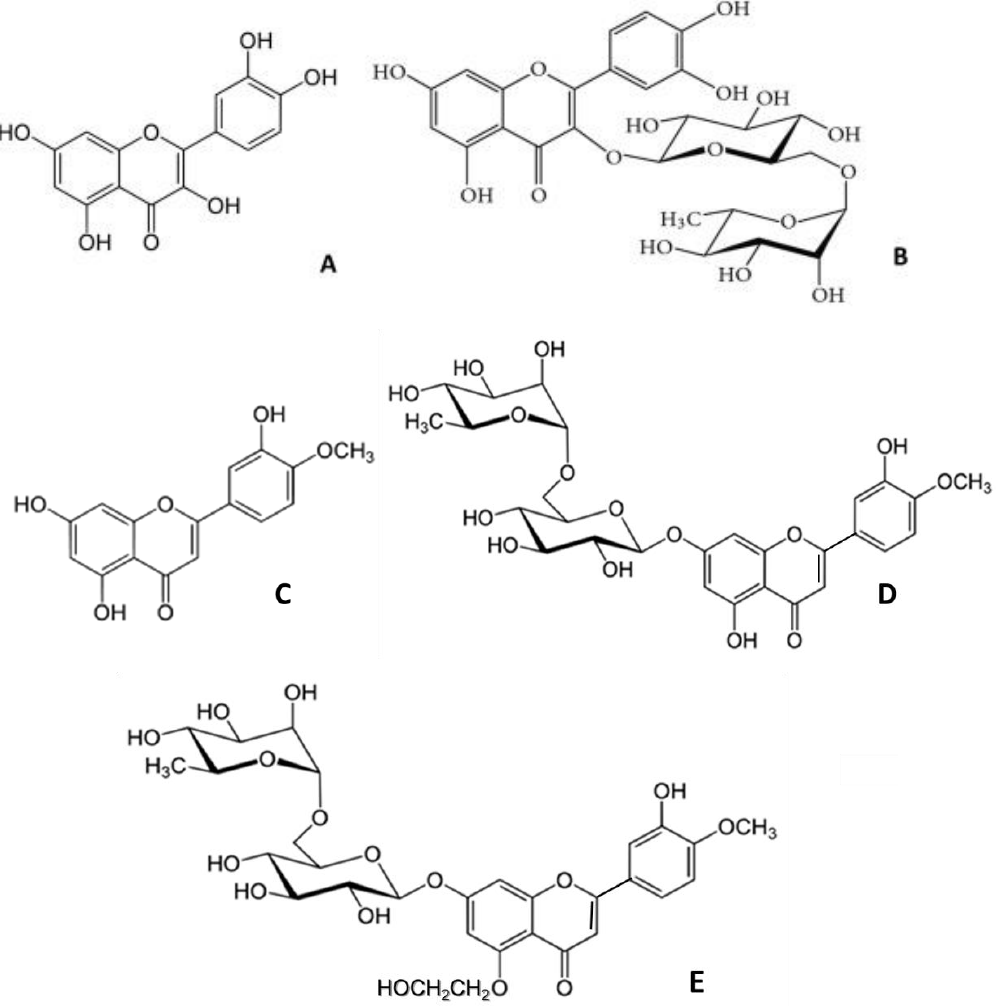
Figure 1. Flavonoids tested: ( A ) quercetin; ( B ) rutin; ( C ) diosmetin; ( D ) diosmin; ( E ) hidrosmin.